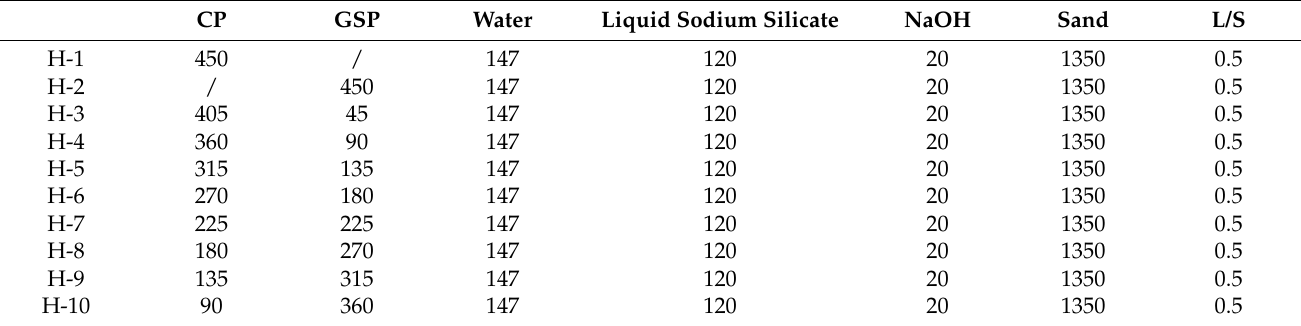
Table 2. Mix proportion of the